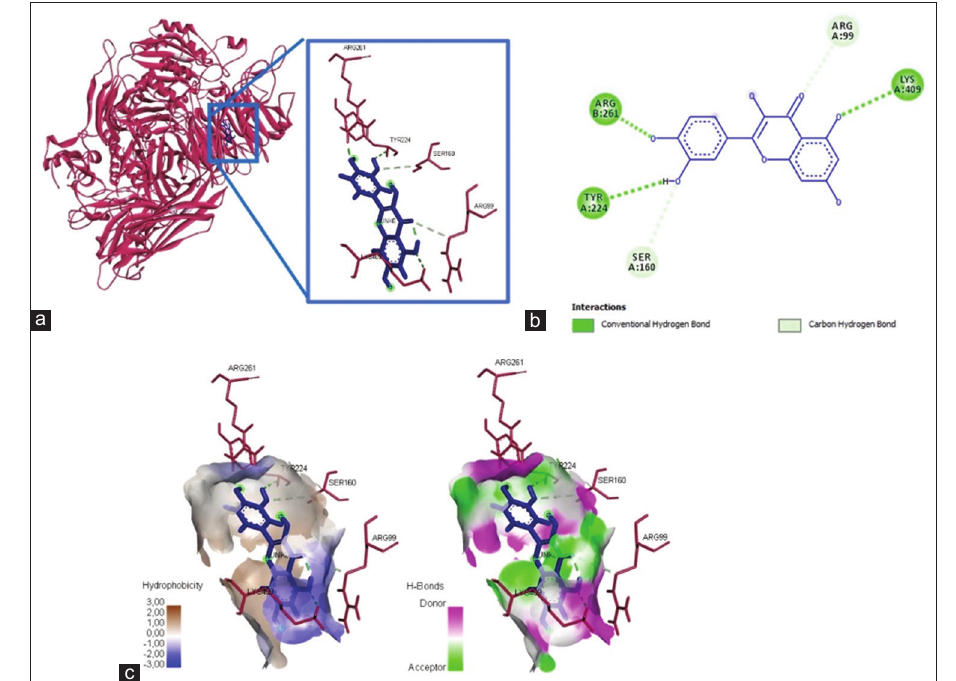
Figure-1: The three-dimensional and two-dimensional structure of the interaction between flavonoid compounds (quercetin) and α v β 3 integrins. (a) Three-dimensional structural interaction between flavonoid-ligand compound quercetin (blue) against α v β 3 integrins on the active binding site (red). (b) This interaction is established by hydrogen and carbon- hydrogen bonds on the active site of the α v β 3 integrin, namely, Arg99, Arg261, Tyr224, and Lys409, which can be seen in the two-dimensional (b) and three-dimensional (c) structures.